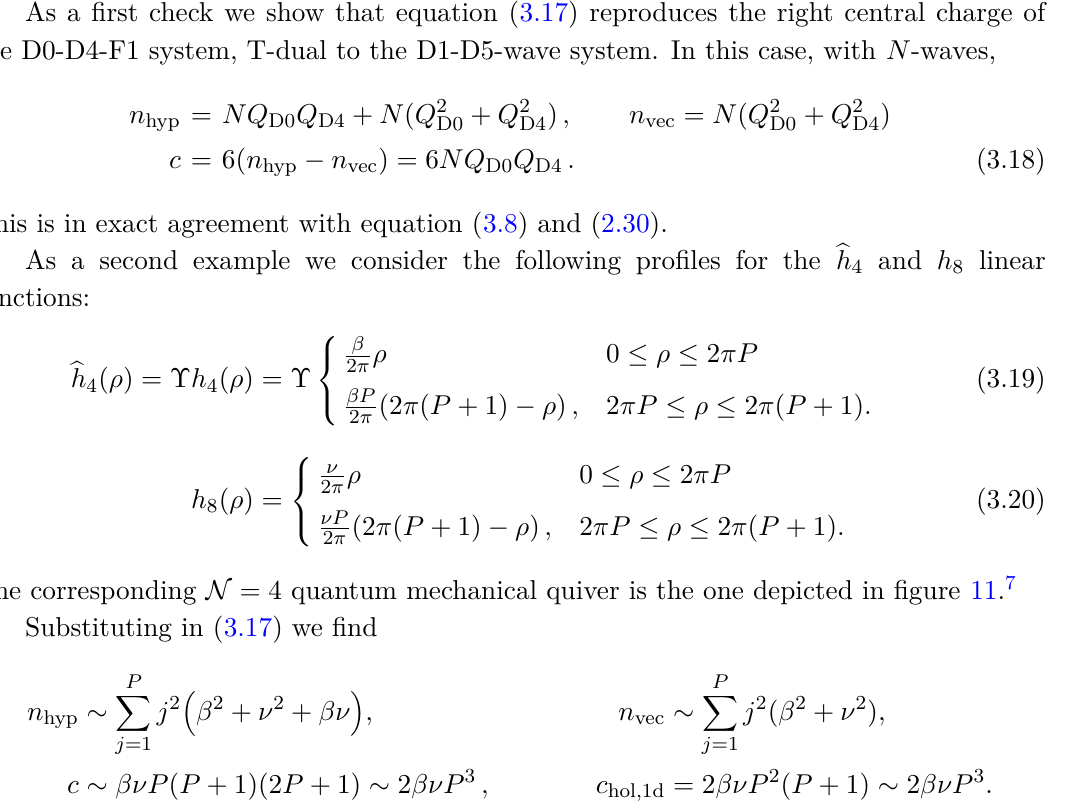
and n are the vec hyp